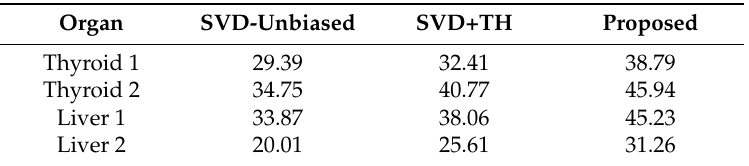
Table 4. SNR values (in dB) of microvessel images of two thyroid nodules and two liver cases using three different filtering methods.